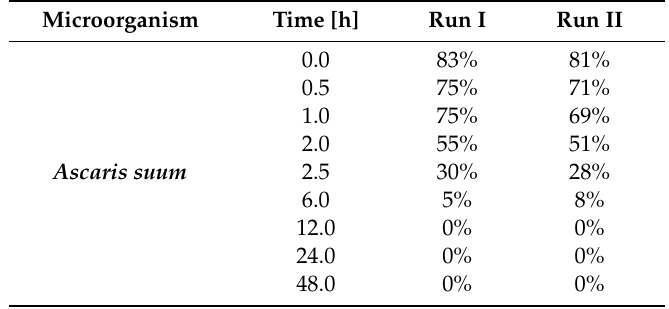
Table 3. The percentage of invasive eggs of the A. suum in laboratory scale.